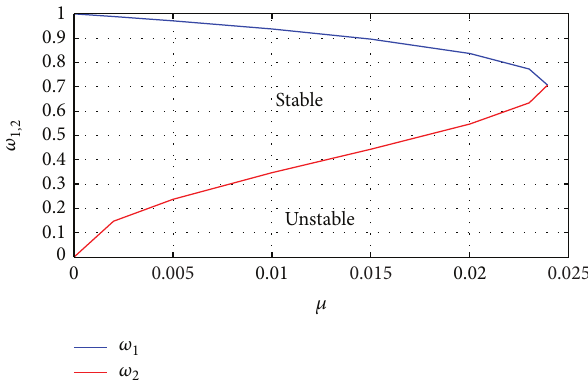
Figure16:Correlationbetween 𝜇 and 𝜔 1,2 forbinarysystemAchird- III.